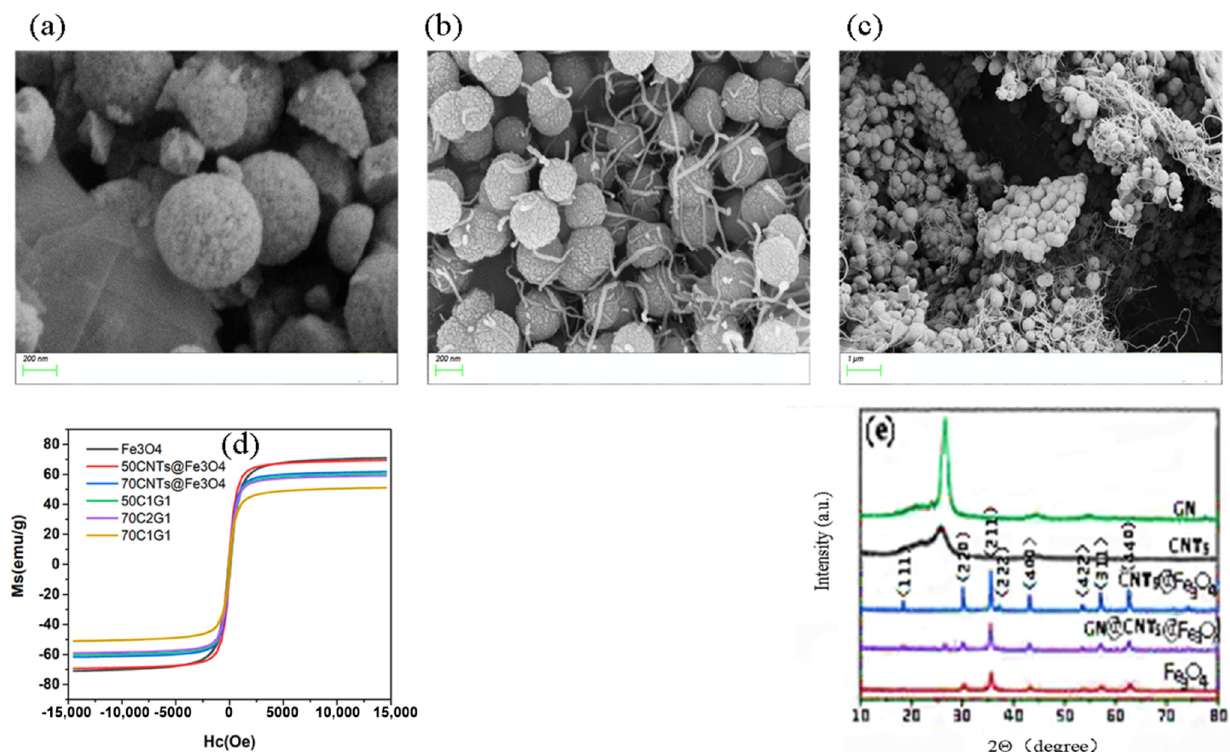
Figure 4. ( a – e )The characterization results of the Fe 3 O 4 /CNTs@Fe 3 O 4 /CNTs@GN@Fe 3 O 4.